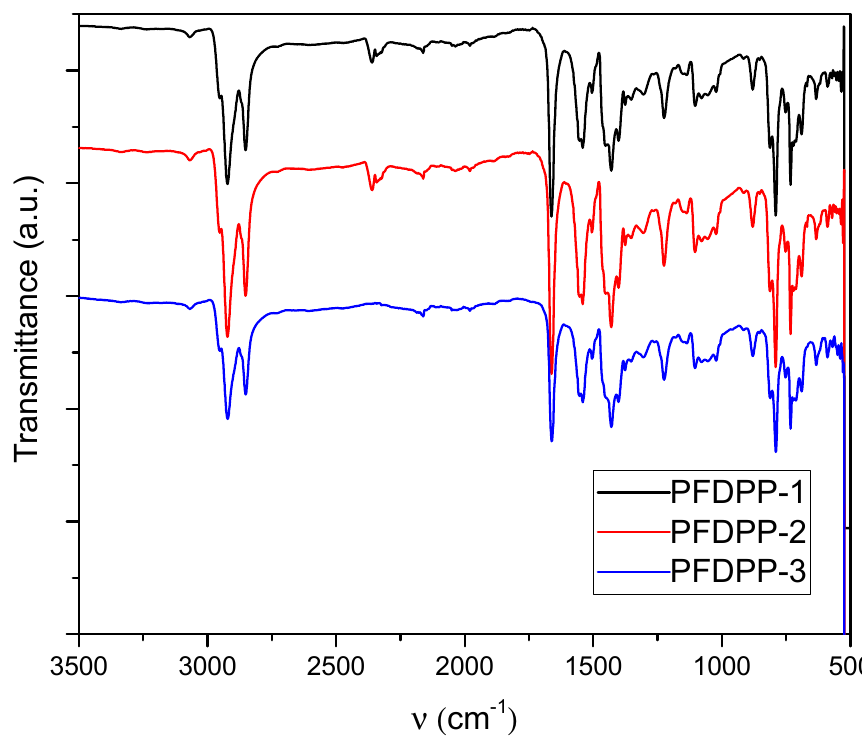
Figure 1. FT − IR spectra of PFDPP polymers.